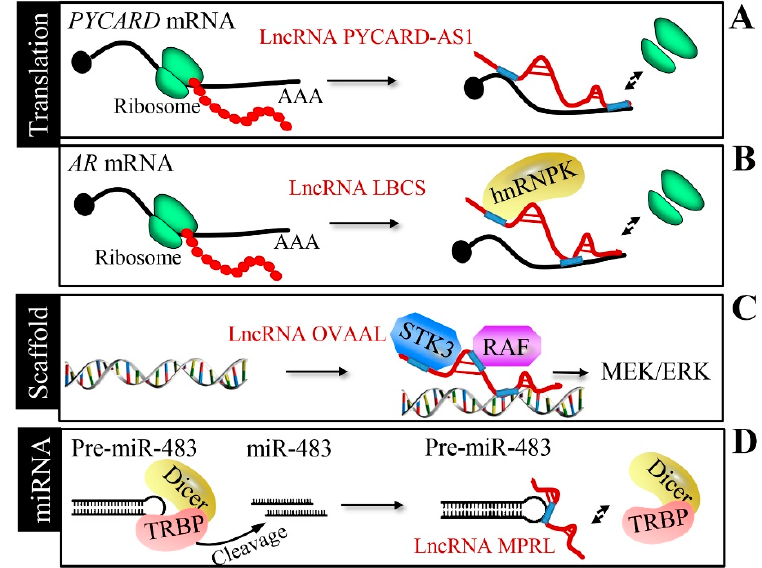
Figure 5. Translation regulation, transcription factor scaffold, and miRNA processing by